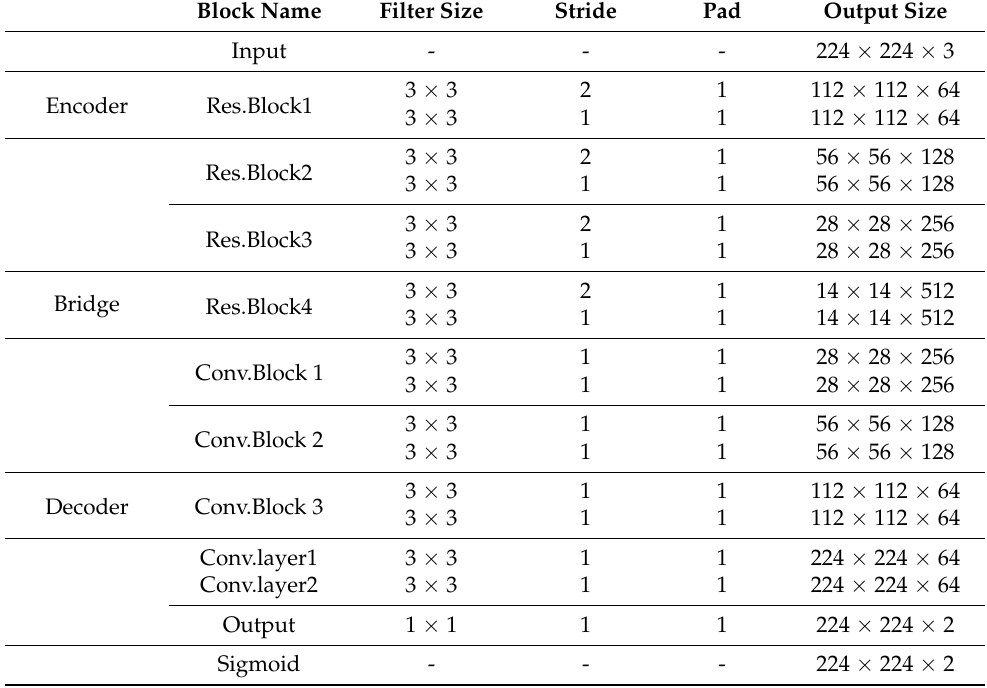
Table 1. The network structure of our previous model